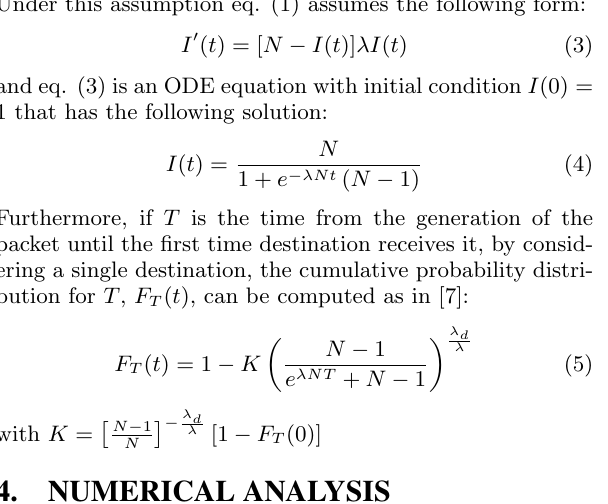
Figure 5: Number of infected nodes vs time for a single plasmid dissemination with a single